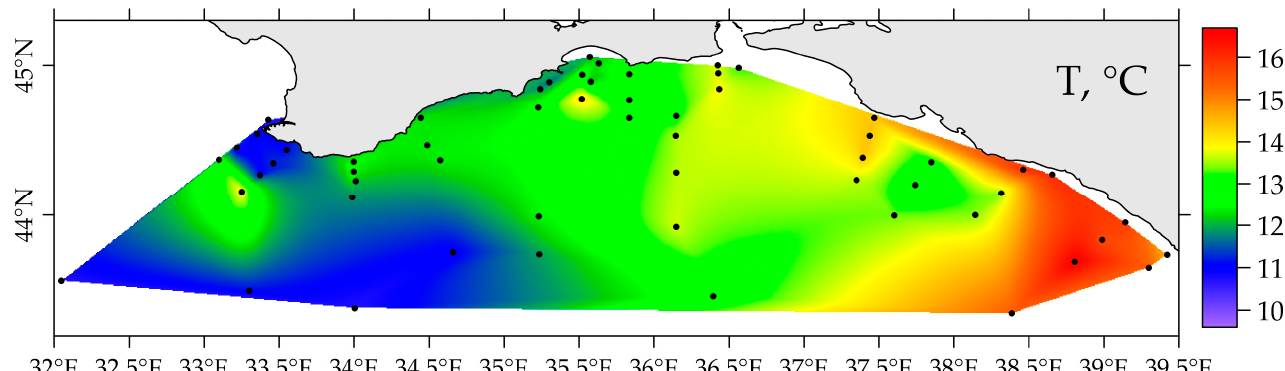
Figure 8. Distribution of temperature in the surface layer in spring